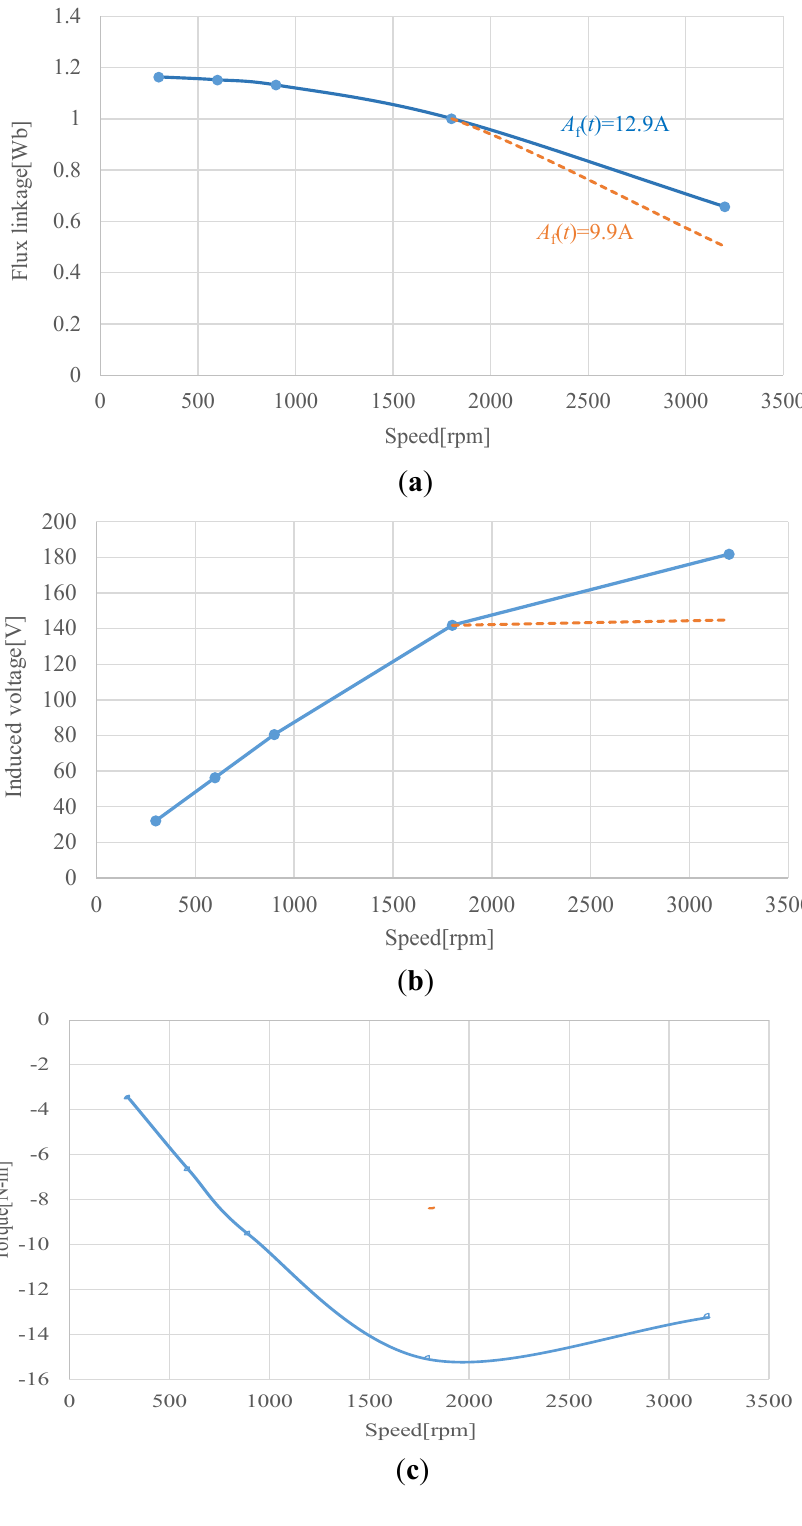
Figure 21. Speed characteristics of Design 8. ( a ) Flux linkage; ( b ) induced voltage; ( c ) torque; ( d ) output power; ( e )